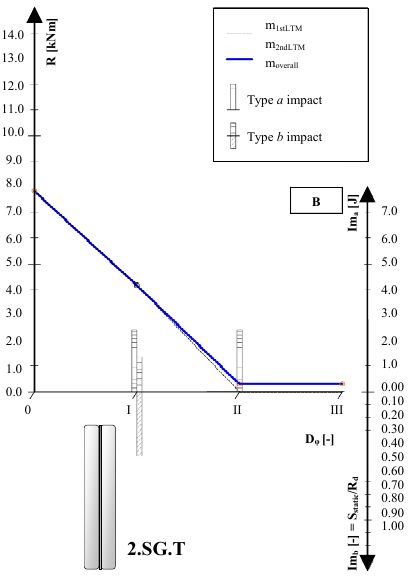
Figure 11: Element Safety Diagram for double layer, SG-laminated, thermally tempered glass beam.